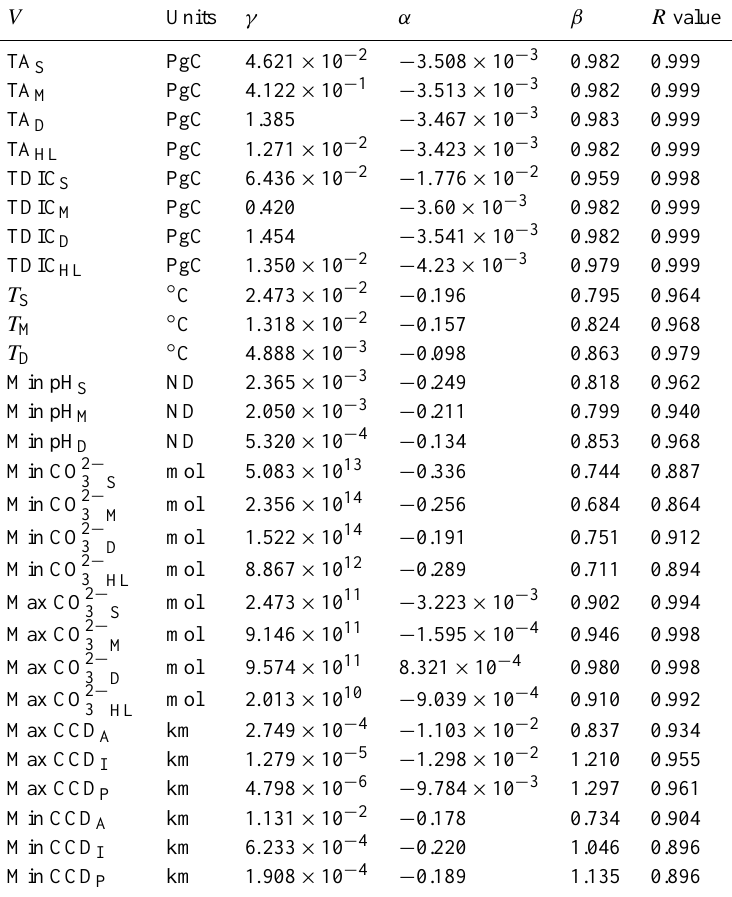
Table 6. Power law scaling for modern configuration, ocean boxes, and (cid:49)V = γD α E β . D in yr and E in PgC.